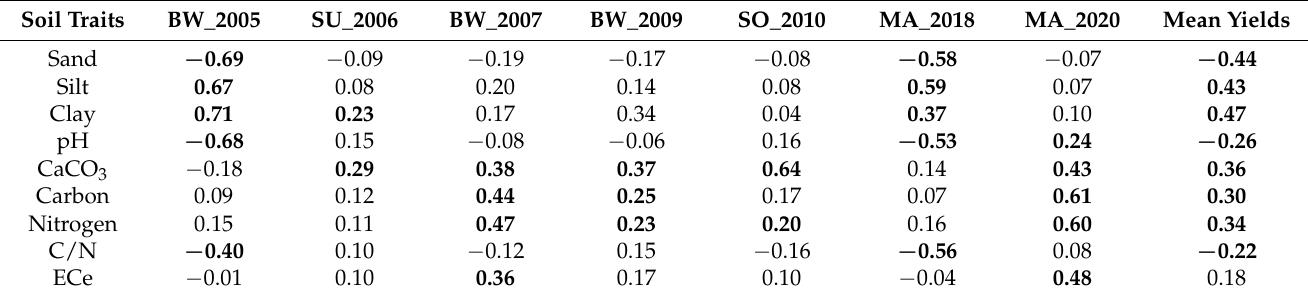
Table 8. Pearson’s correlations between soil traits and crop yields ( n =